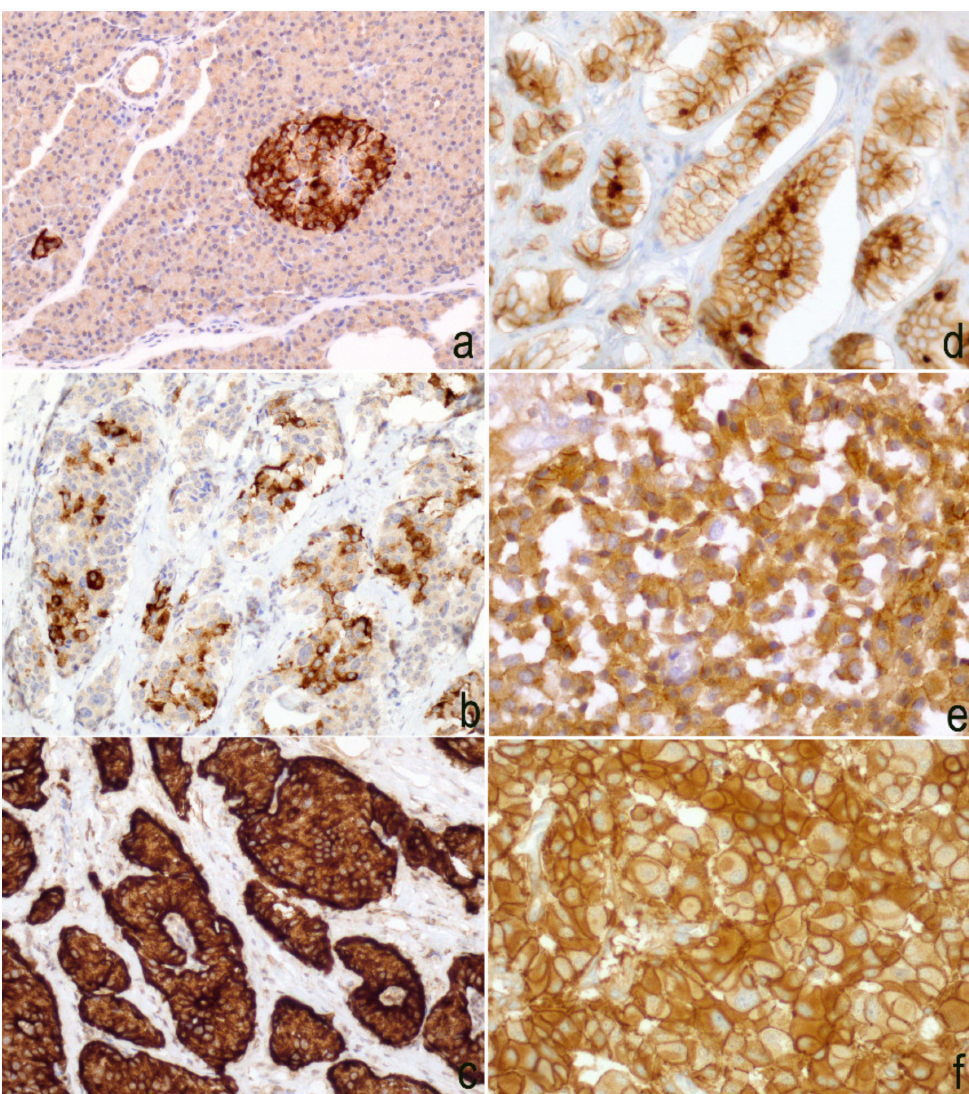
Figure 5. Slug immunoscore—( a ) an intense cytoplasmic immunoreaction was evident in the normal pancreatic tissue that was located exclusively in the neuroendocrine compartment. Negative scores were exocrine pancreas (20 × magnification); ( b ) cytoplasmic signal was observed in 15–50% of neoplastic cells (20 × magnification); ( c ) in this field, strong and di ff use ( > 50%) immunoreaction was detected in neoplastic cells (40 × magnification); ( d ) 20 × magnification, and ( e ) 40 × magnification. E-cadherin expression was reduced compared to cases where the expression was preserved ( f ) 40 ×